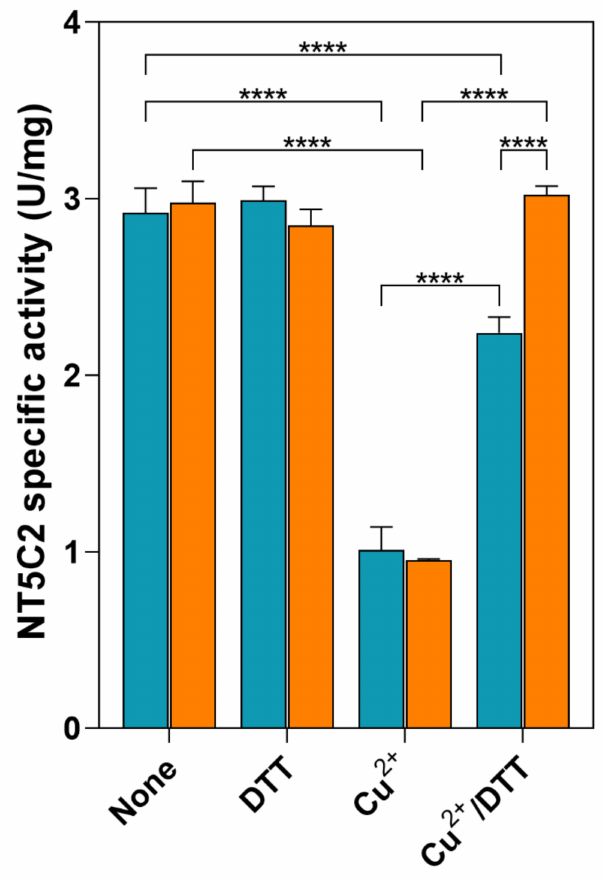
Figure 3. Effect of oxidative stress on the activity of recombinant WT and C547A NT5C2. The activity of recombinant NT5C2, both the WT (blue bars) and C547A mutant (orange bars), was measured after incubation in the absence (none) and the presence of either 5-mM dithiothreitol (DTT) or of 300- µ M CuCl 2 (Cu 2+ ) . The activity was also measured after the addition of 5-mM DTT to the mixtures treated with 300- µ M CuCl 2 (Cu 2+ /DTT). Results are the mean ± SD of at least three independent experiments. Statistical significance: **** p <